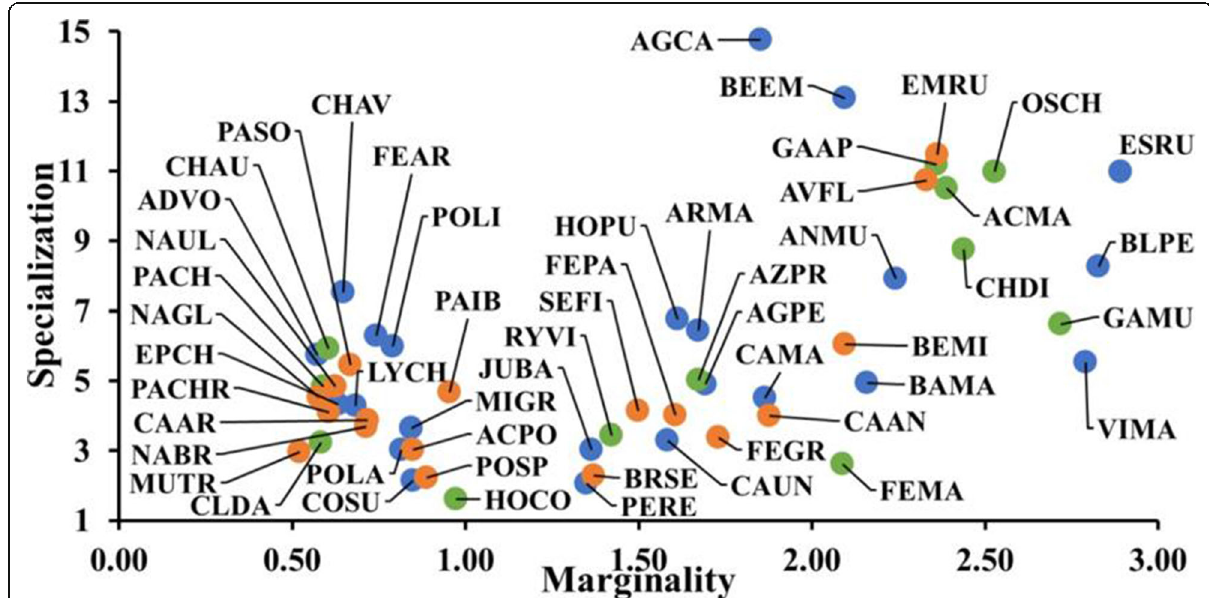
Fig. 3 Specialization (low species ’ variance compared to the global variance of all sites) vs. marginality (large difference of species ’ mean compared to the mean of all sites) of indicator vascular plant species, classified according to the number of times that the species were selected for each ecological area (blue = one ecological area, green = two ecological areas, orange = more than three ecological